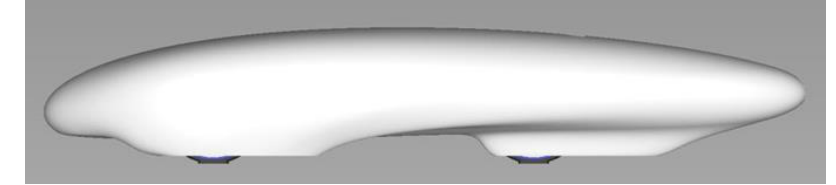
Figure 2. IDRAkronos’ external shape.